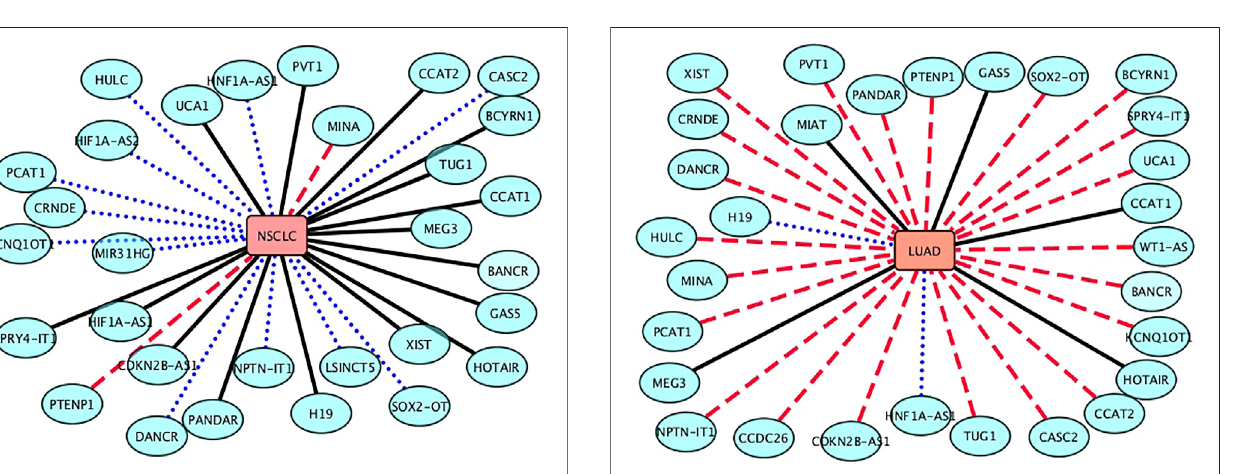
The bold values denotes lncRNAs that were predicted to associate with LUAD and need to further validate in Table 4 .